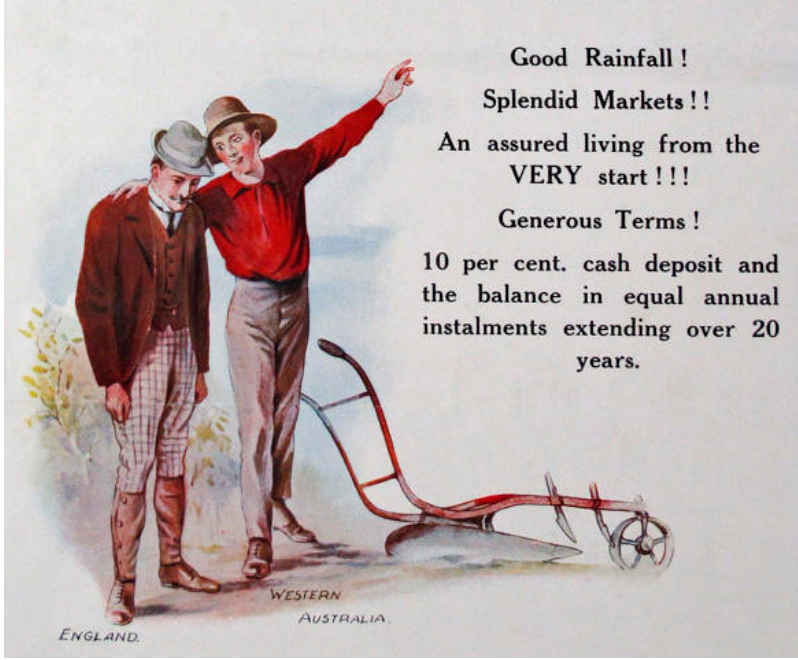
Figure 7. Midland Railway advertisement for farmland. Source: Carnamah Historical Society.